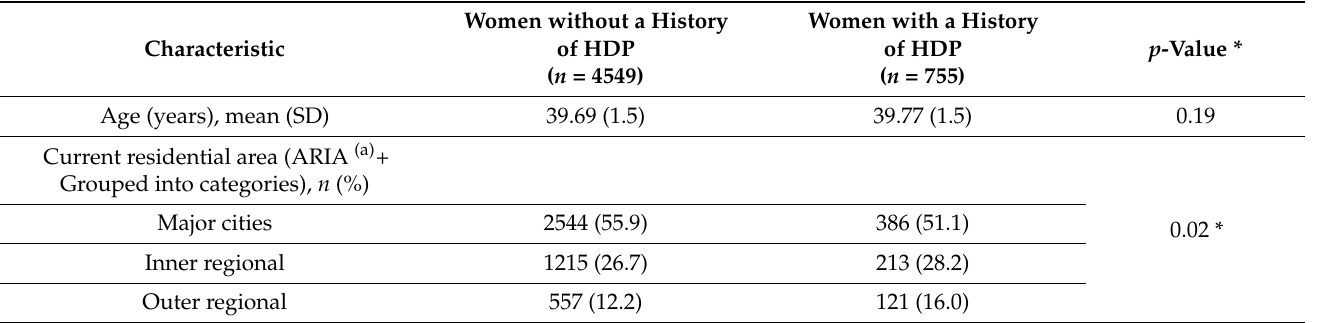
Table 2. Socio-demographic characteristics and health status of women categorised by their history of HDP.